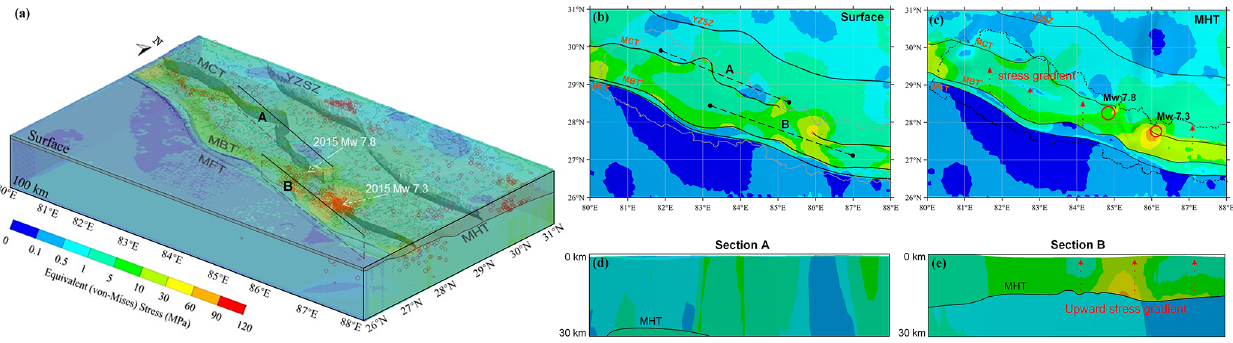
Figure 6. The spatial distribution of equivalent stress in a 3D perspective (a) , on the surface (b) and MHT (c) , and on Sects. A (d) and B (e) . Red circles in (a) represent the hypocenters of seismic activities ( M w ≥ 3 . 0, 1921–2022) from